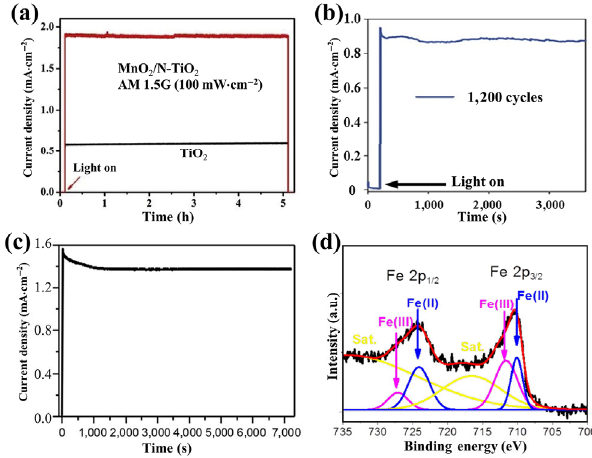
Figure 4 (a) I – T curves of TiO 2 and MnO 2 /N-TiO 2 at a voltage of 1.23 V vs. RHE. Reproduced with permission from Ref. [70], © Elsevier B.V. 2020. (b) I – T curves of a stainless steel 3D-printed electrode loaded with ALD TiO 2 for 1,200 cycles at 1.23 V vs. RHE under illumination. Reproduced with permission from Ref. [71], © WILEY-VCH Verlag GmbH & Co. KGaA, Weinheim 2019. (c) I – T curves of the CP-FeO x /TiO 2 photoanode under continuous illumination at 1.23 V vs. RHE. (d) XPS spectra of CP-FeO x /TiO 2 after PEC stability testing. Reproduced with permission from Ref. [73], © American Chemical Society